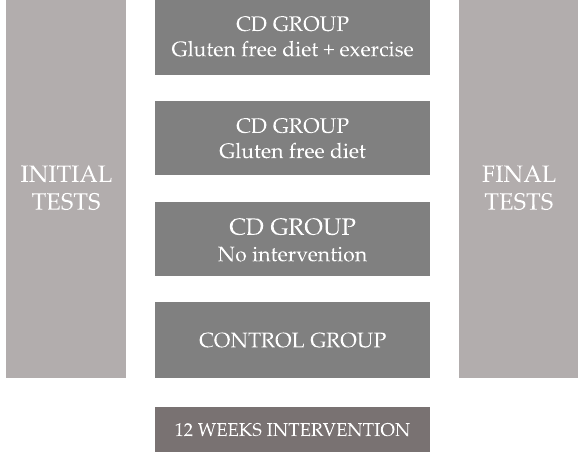
Figure 2. Design and development of the study. CD = celiac disease.